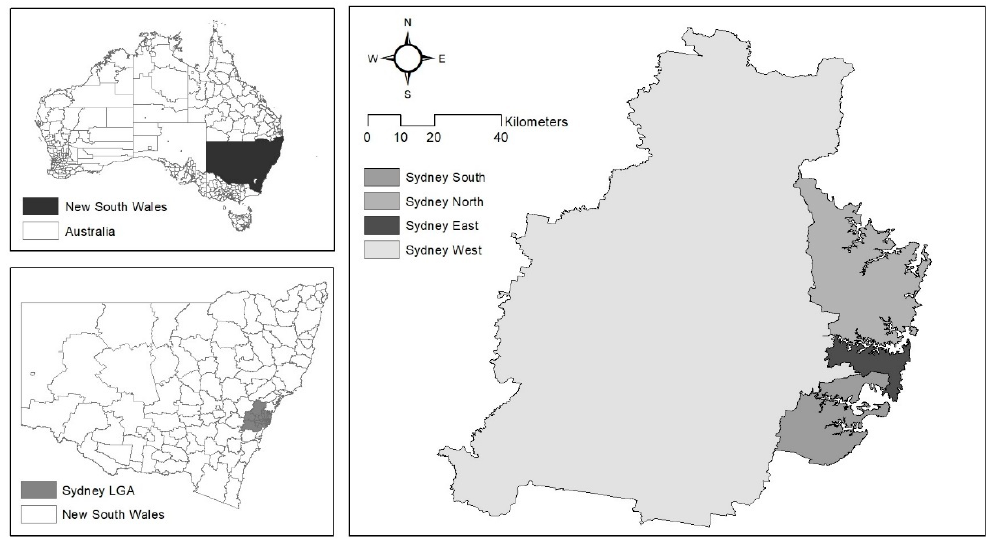
Figure 1. Four subregions in Greater Sydney. Source: authors’ own.